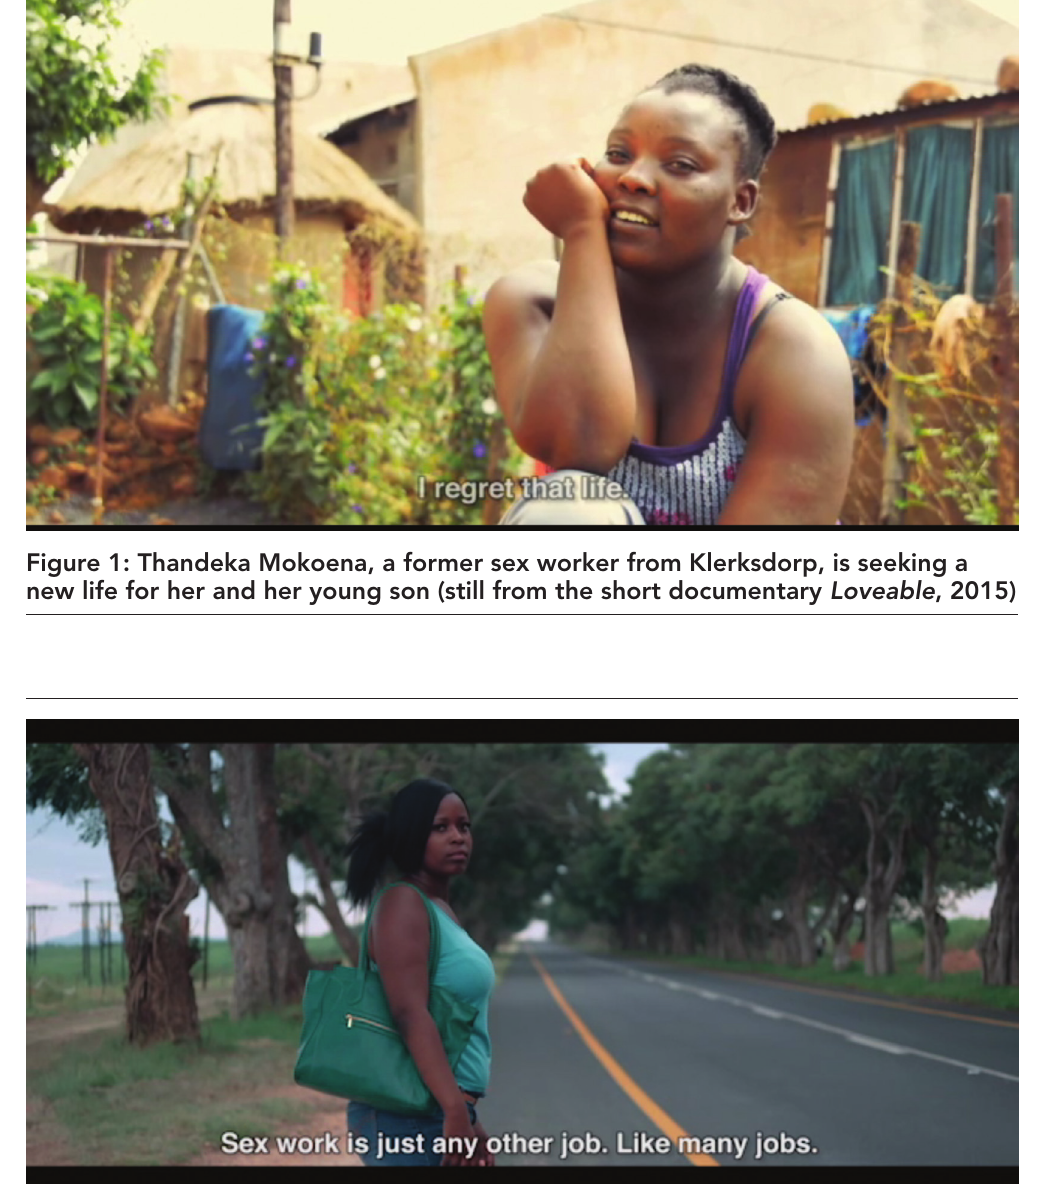
Figure 2: A sex worker in Nelspruit is looking for customers while she reflects on the nature of her work (still from the short documentary Forbidden Fruit ,